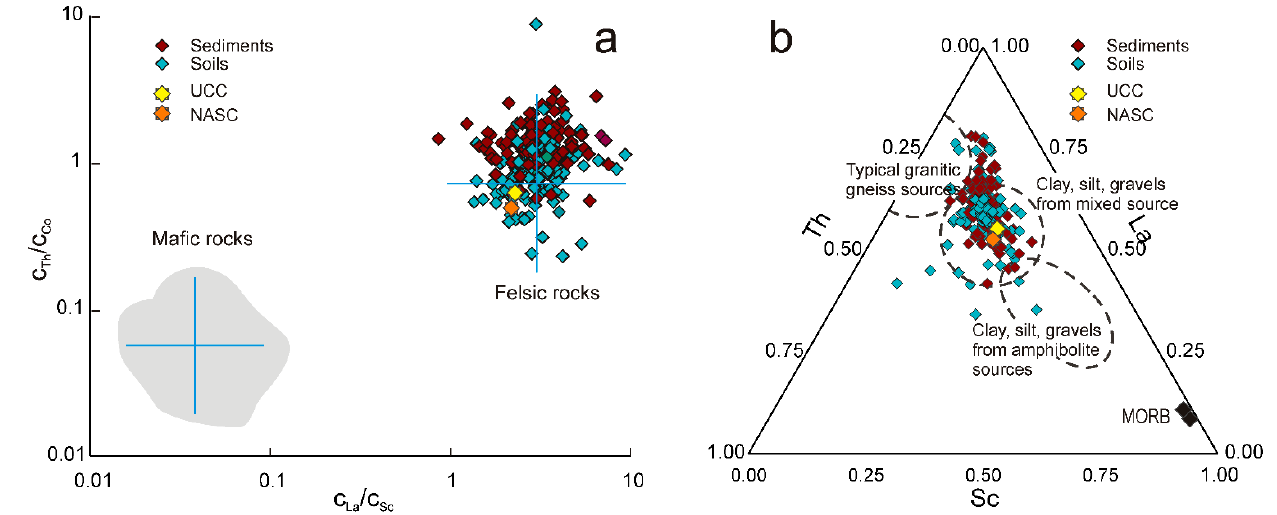
Figure 5. Discriminating bi-plots La/Th vs Hf ( a ) and Th/Sc vs. Zr/Sc; ( b ) confirming the felsic origin of Zarafshon sediments and soils as well as the absence of a significant recycling of sedimentary material.